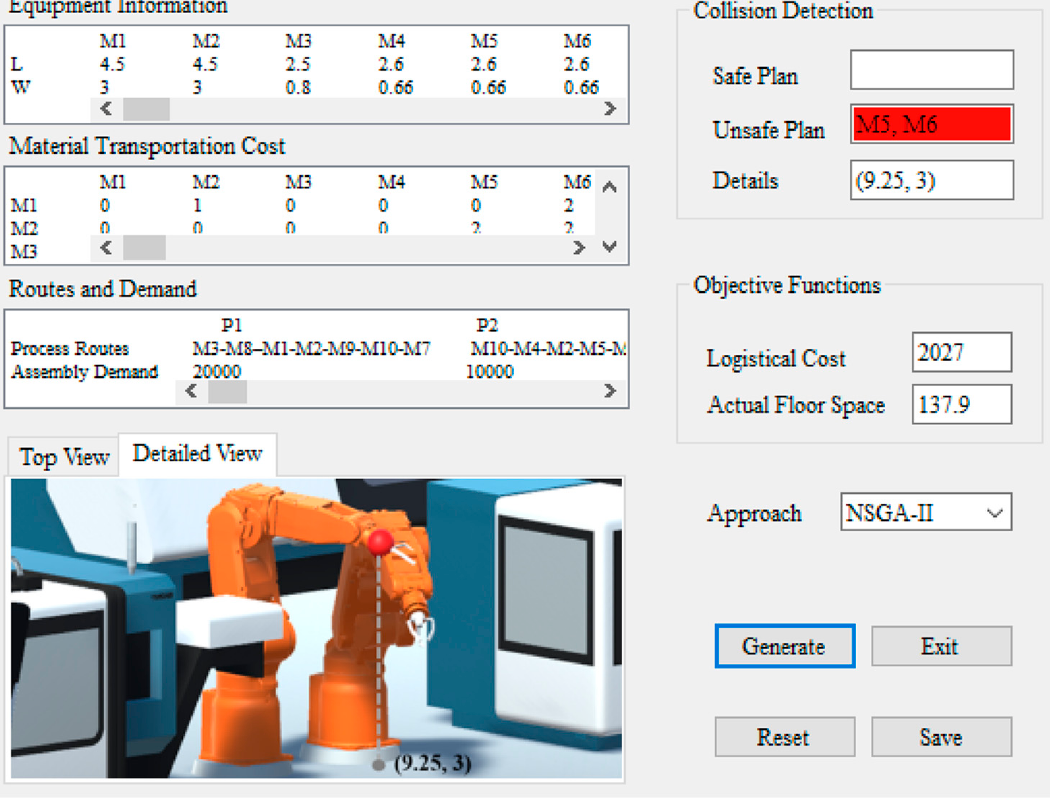
Figure 10. Top view of safe and optimal layout by SE-NSGA2. 5. Conclusions and Outlook This paper proposes a systematic optimization approach in order to generate a safe layout plan for assembly lines with robots. The modeling rules for robots and irregular equipment are presented, and a combined SE-NSGA2 method that is based on NSGA-II and the DE strategy is used for